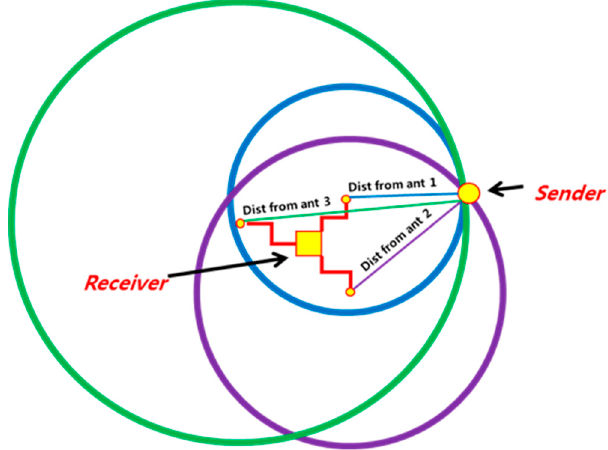
Figure 6. Use of TDoA for localization.